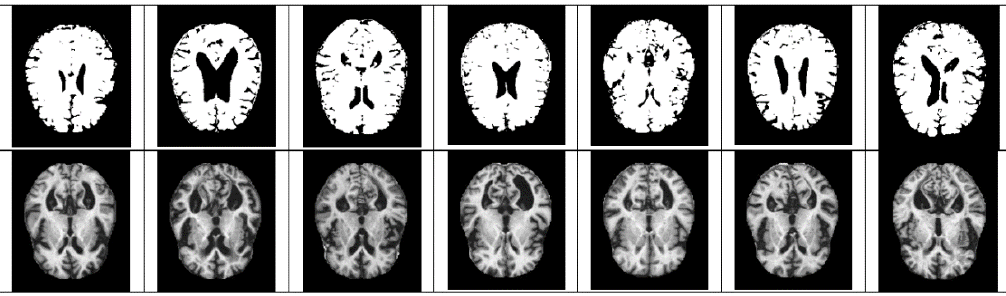
Figure 6. Quantized mild examples ( above ), original very mild examples ( below ).